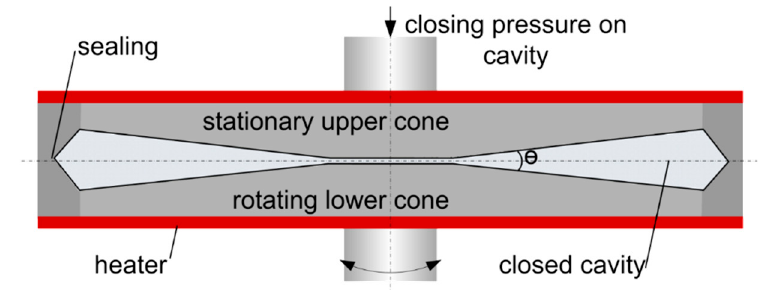
Figure 1. Closed cavity rheometer used for rheological measurements (picture taken from Emin and Schuchmann, 2017